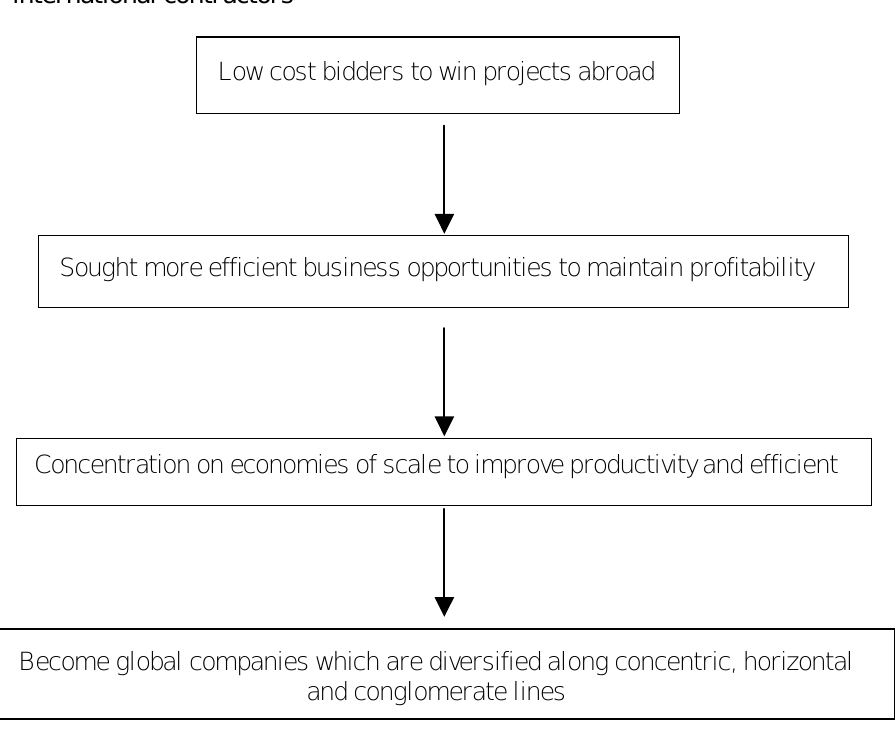
Figure 1: The various stages that Turkish contractors passed in their progress towards international